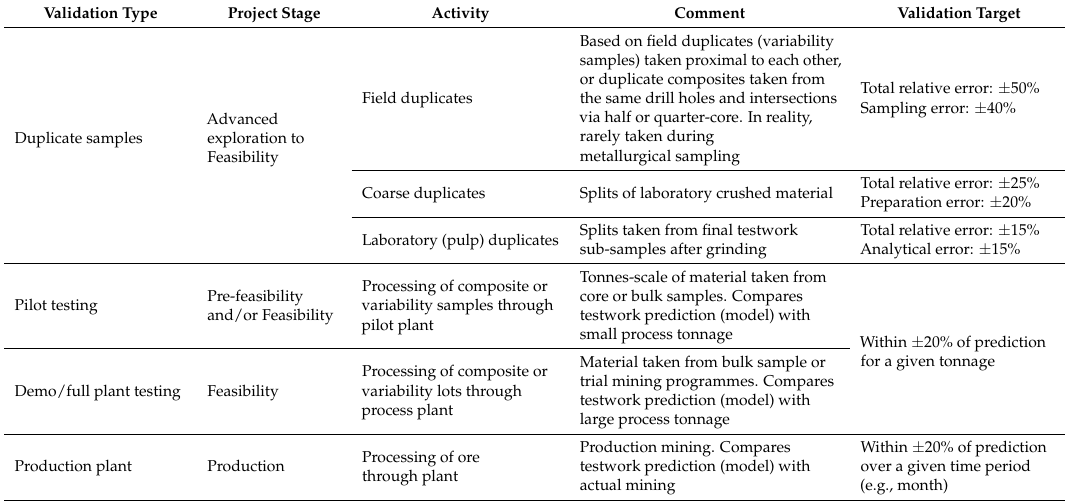
Table 14. Metallurgical sampling and testwork validation actions across the MVC.